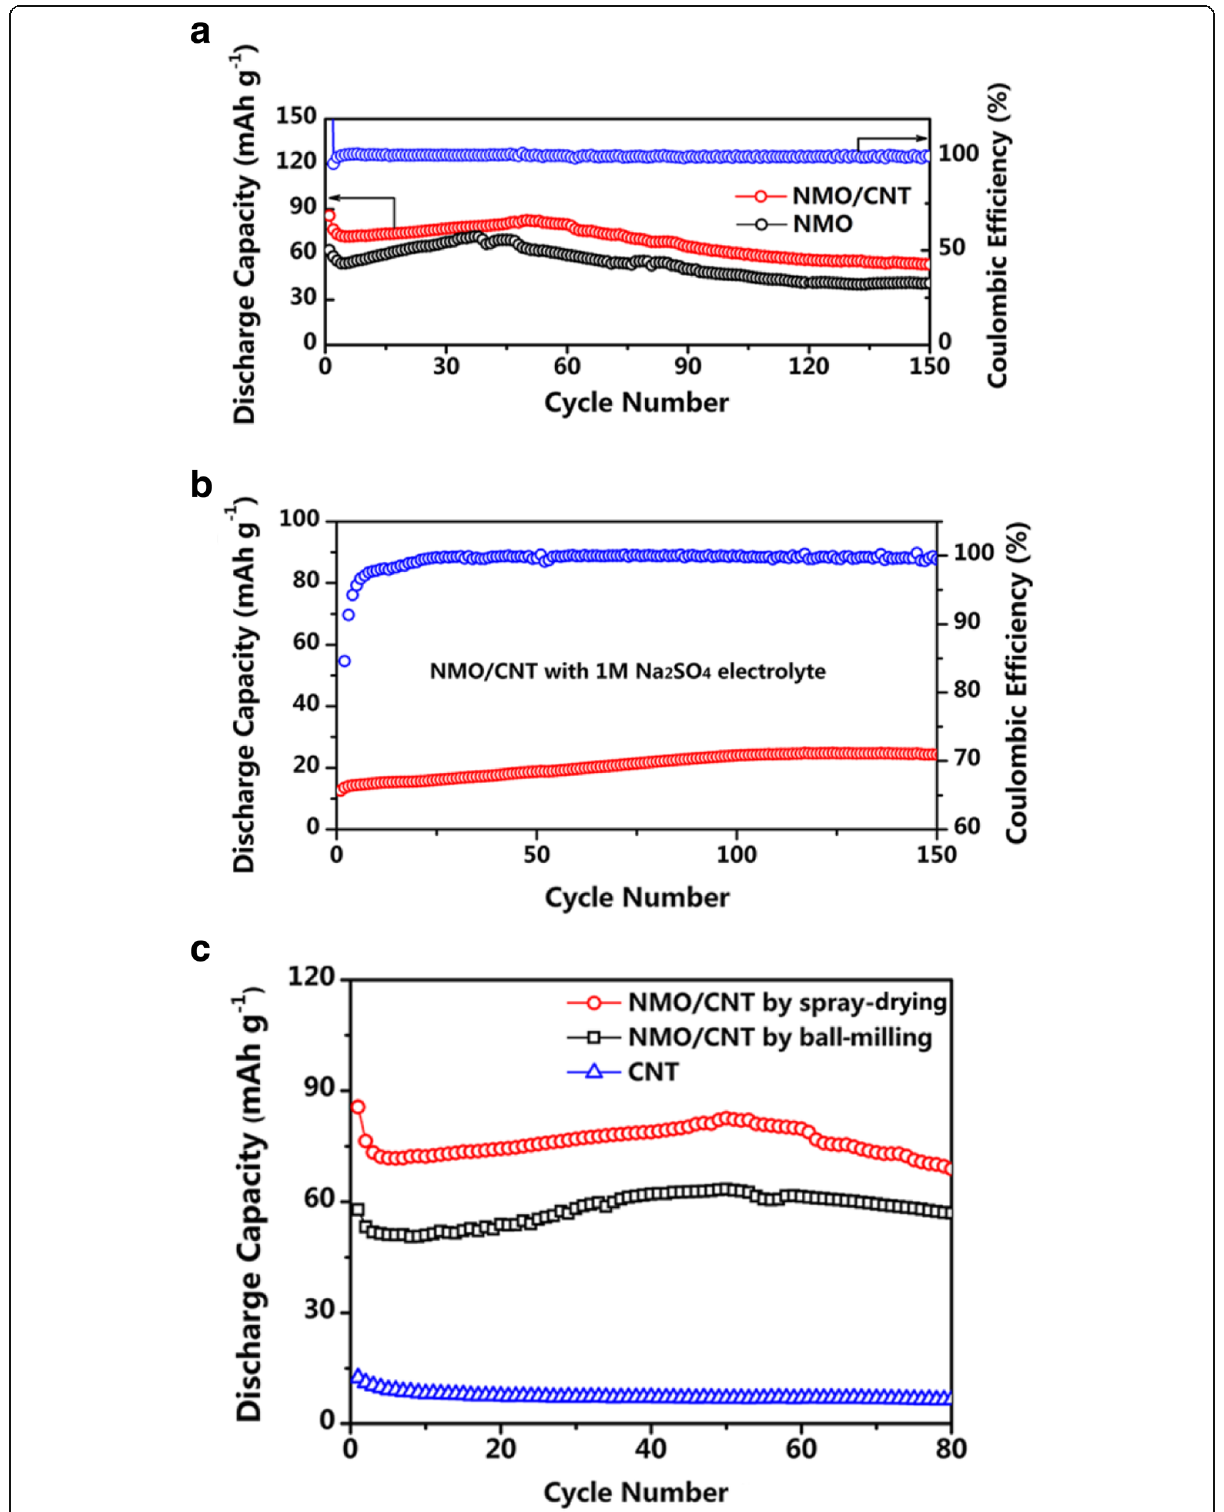
Fig. 5 Cycling performances at 4 C. a Cycling performance comparison of NMO and NMO/CNT electrodes and coulombic efficiency of NMO/CNT electrode. b Cycling performance and coulombic efficiency of NMO/CNT electrode with 1 M Na 2 SO 4 electrolyte. c Cycling performance comparison of NMO/CNT electrodes via the spray-drying method and ball-milling method,